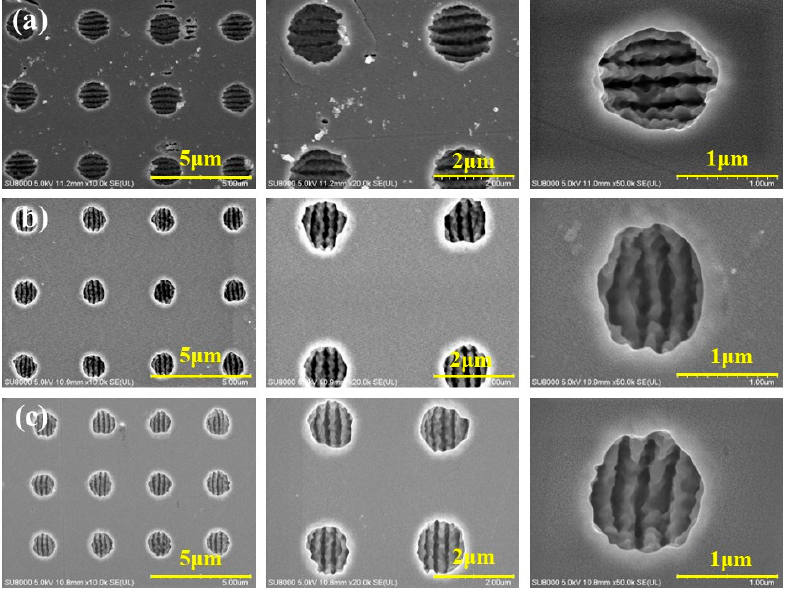
Figure 2. SEM images of micropore arrays with different periods. ( a ) 3.6 μ m period; ( b ) 3.0 μ m period; ( c ) 2.6 μ m period.